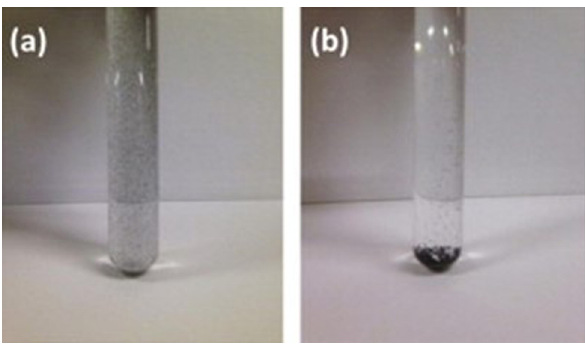
Figure 7: Stability of dispersions of MWCNT/water after ( a ) 0 h and ( b ) 24 h [ 82 ] .